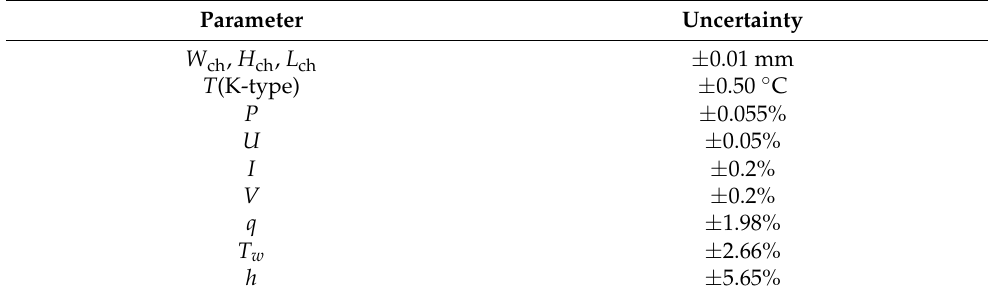
Table 1. Uncertainties of